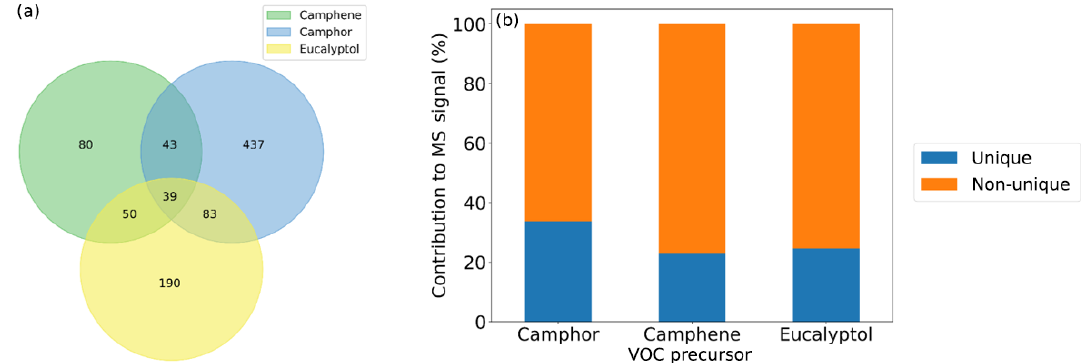
Figure 2. (a) Comparison of ions from peak lists of individual volatile organic compound precursors (number of ions shown in Venn diagram). (b) The contribution of unique and non-unique products to the total signal derived from the Venn diagram under low-NO x conditions.